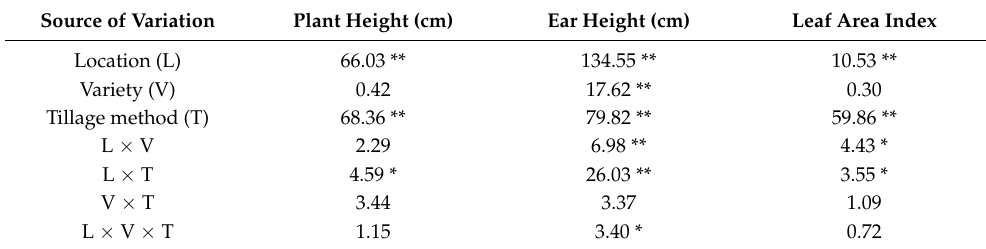
Table 6. Analysis of variance of maize agronomic traits following each treatment